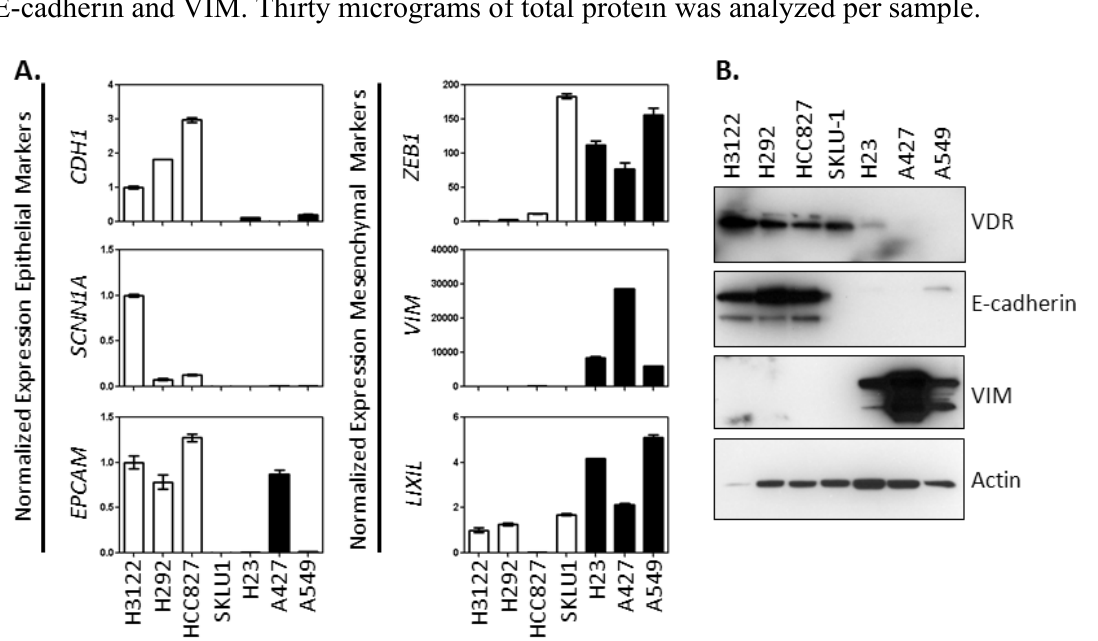
Figure 1. NSCLC cells that are VDR high and vitamin D-sensitive preferentially express markers of an epithelial phenotype. The indicated NSCLC cell lines were grown under basal growth conditions until they achieved 50%–70% confluence. ( A ) RNA was extracted and used to prepare cDNA. One microliter of each cDNA was used in a quantitative PCR assay to measure expression of representative epithelial markers ( CDH1 , SCNN1A , and EPCAM ) and mesencyhmal markers ( ZEB1 , VIM , and LIX1L ). Data are the mean ± SD for triplicate determinations within a single experiment. Data were normalized to that obtained for H3122 cells. H3122 gene expression was arbitrarily assigned a value of 1.0. VDR high cells are indicated with white bars. VDR low cells are indicated with black bars; ( B ) Protein was extracted 24 h post-seeding of 5 × 10 6 cells and analyzed by immunoblot for VDR, E-cadherin and VIM. Thirty micrograms of total protein was analyzed per sample.